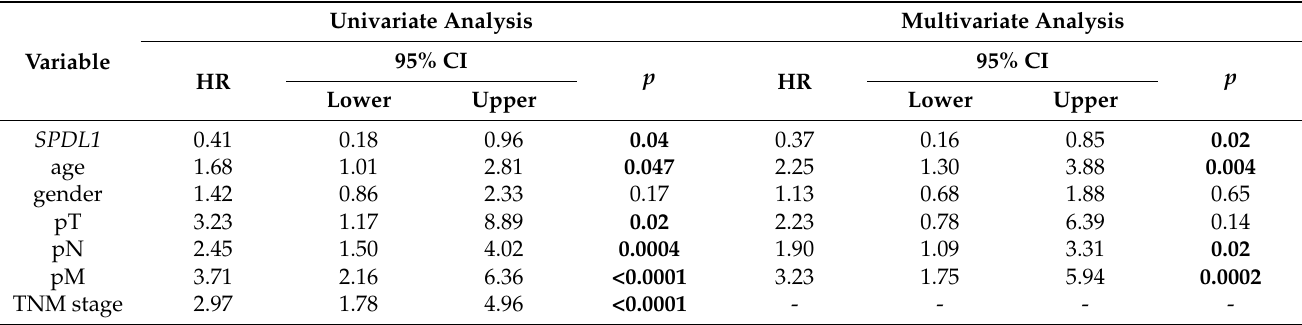
Table 4. Univariate and multivariate Cox regression analyses of OS for CRC patients in TCGA cohort ( n =